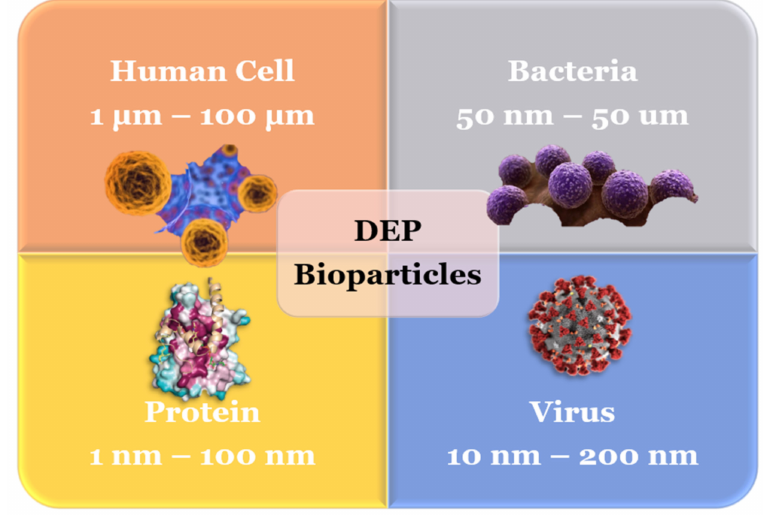
Figure 2. Bioparticles that have been studied with DEP